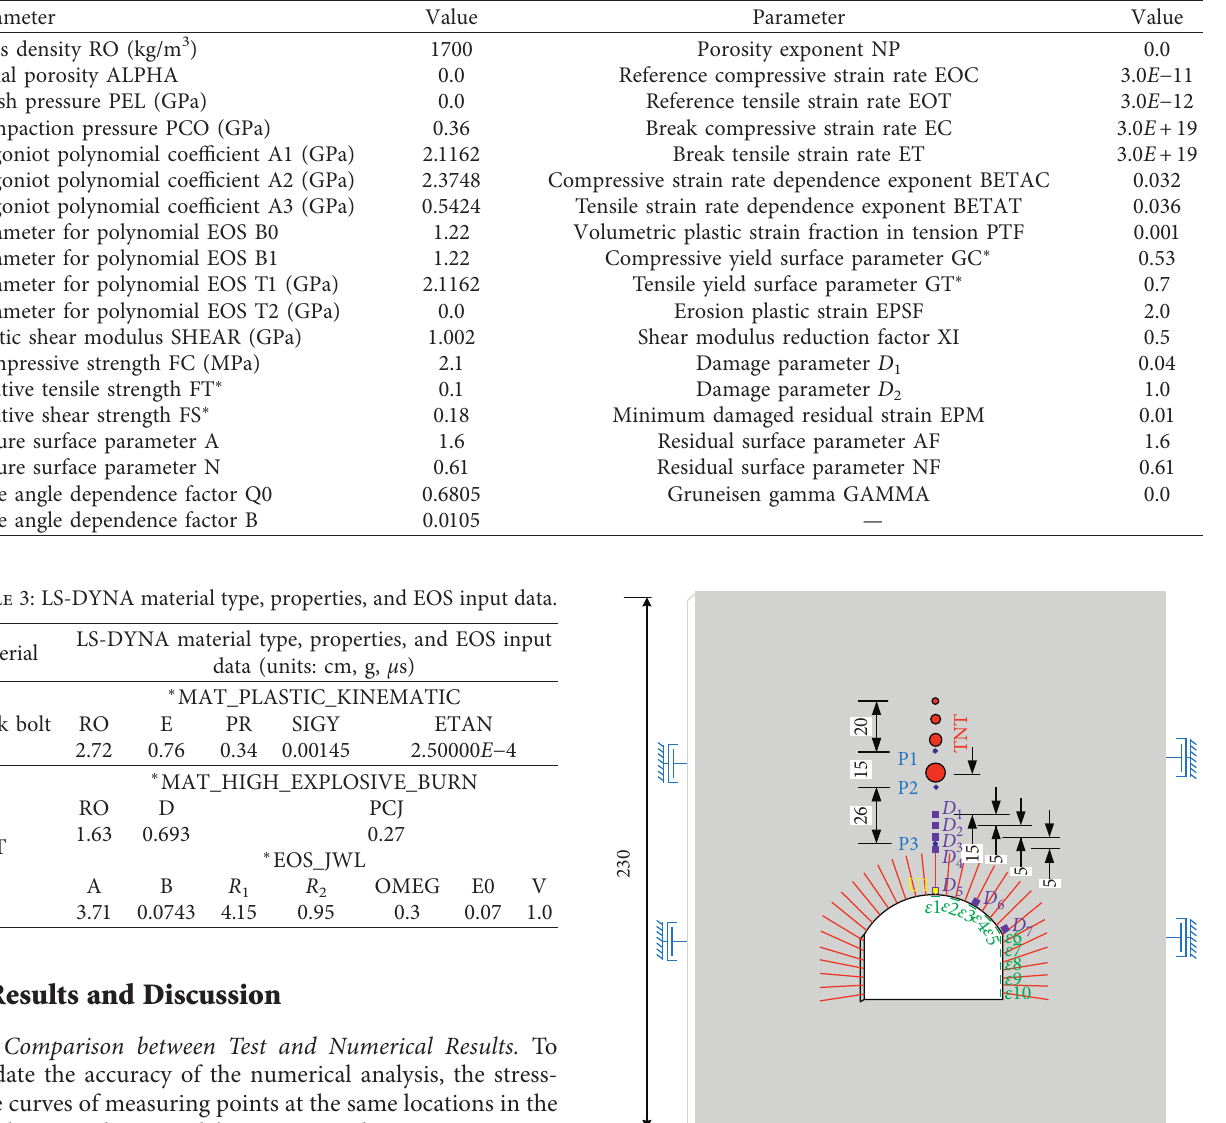
Table 2: Parameters for Riedel–Hiermaier–Thoma (RHT) model of the rock mass.